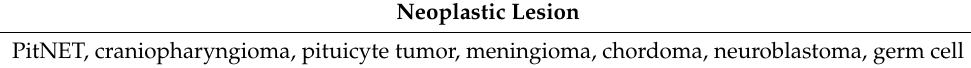
Table 3. Typical neoplastic or mass lesions in and around the pituitary gland. Neoplastic